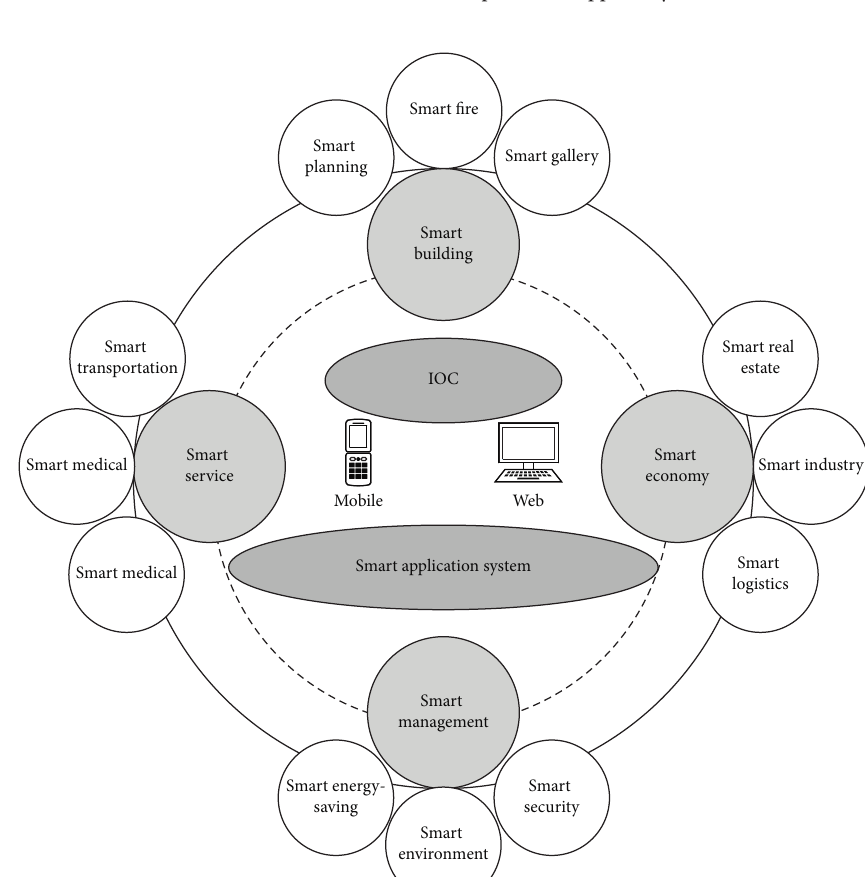
Figure 5: The structure of the smart system layer.